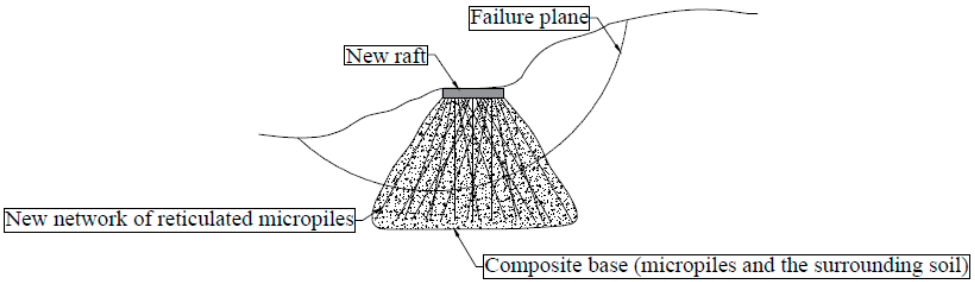
Figure 3. Reticulated network of MPs that form a composite base, used for soil stabilization (after [3]).